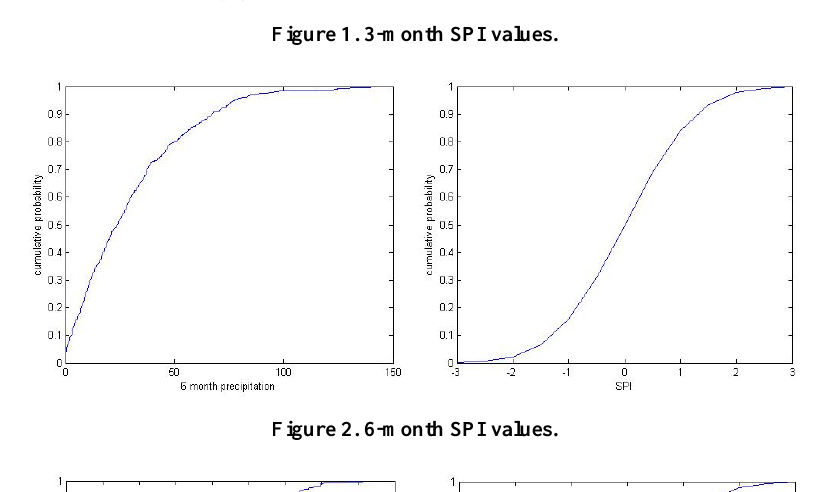
Figure 1. 3-month SPI values.